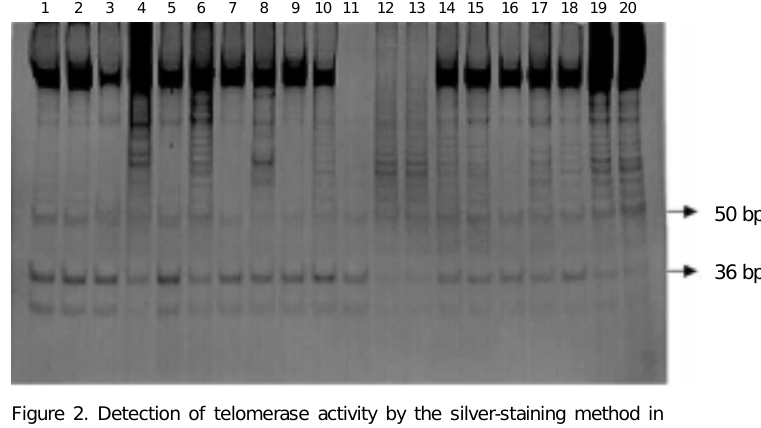
Figure 2. Detection of telomerase activity by the silver-staining method in papillary thyroid carcinomas (NPA), follicular thyroid carcinomas (WRO), undif- ferentiated thyroid carcinomas (ARO), and all leukemia samples. NPA cell line (lane 20); WRO cell line (lane 19); undifferentiated thyroid carcinoma (lanes 17, 18); mixed thyroid carcinoma (lane 16); mixed thyroid carcinoma (papillary/ medullar thyroid carcinoma) (lane 15); papillary thyroid carcinoma (lanes 4, 5, 14); TSR8 control (lanes 12, 13); primer-dimer control (lane 11); mixed thyroid carcinoma (follicular/medullar thyroid carcinoma) (lane 10); normal control (lanes 7, 9); Goiter (lane 8); follicular thyroid carcinoma (lanes 1, 3, 6); lymph node metastases from papillary thyroid carcinoma (lane 2) (9.8 x 4.6 cm;